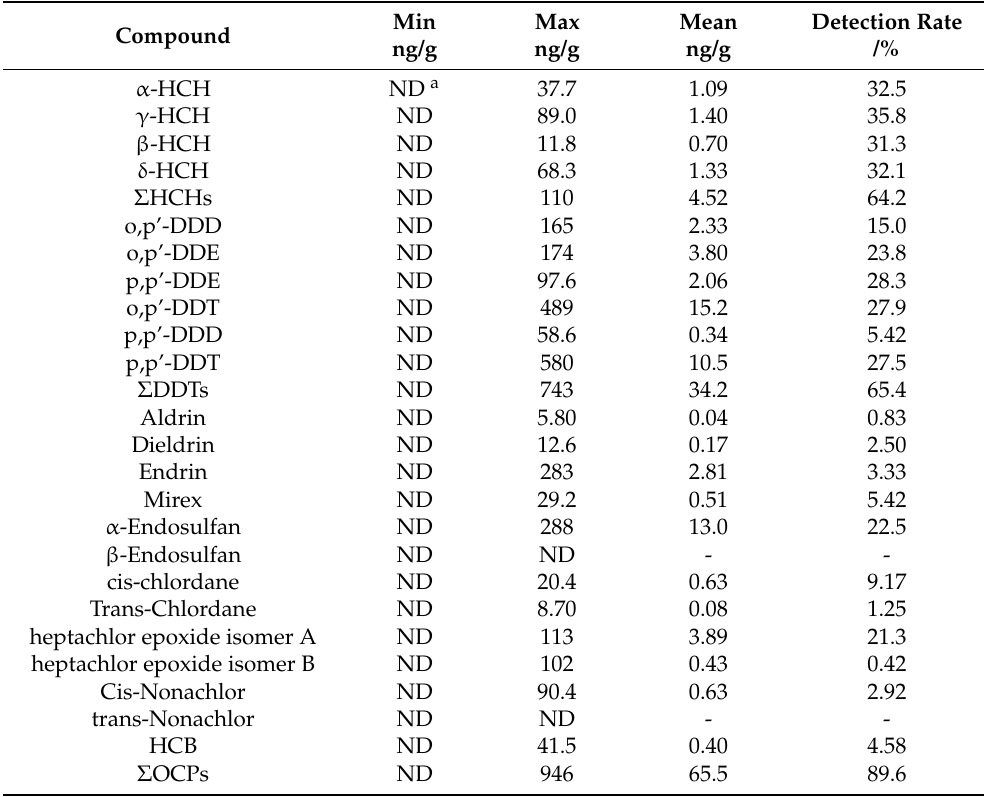
Table 1. Concentration of 23 OCPs in agricultural soil samples of the Pearl River Delta.